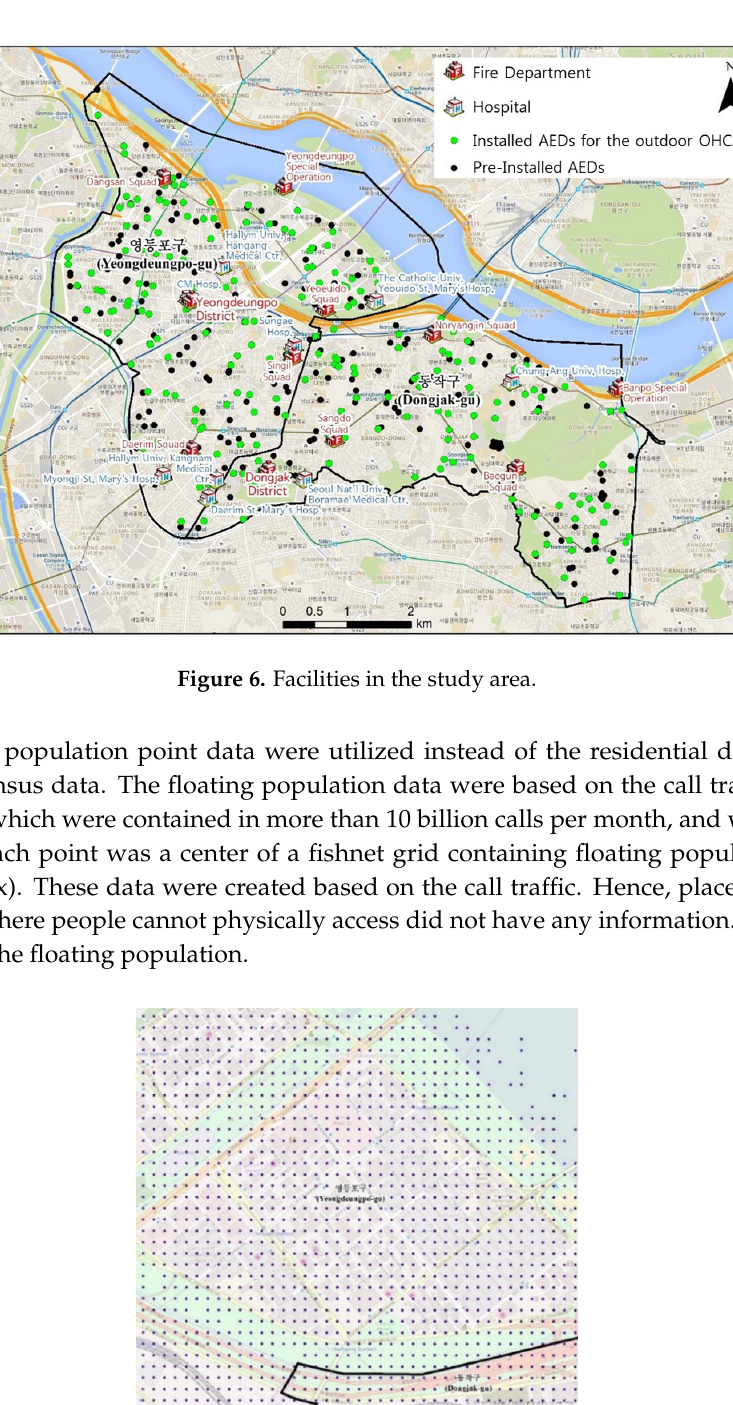
Figure 7. Floating population.